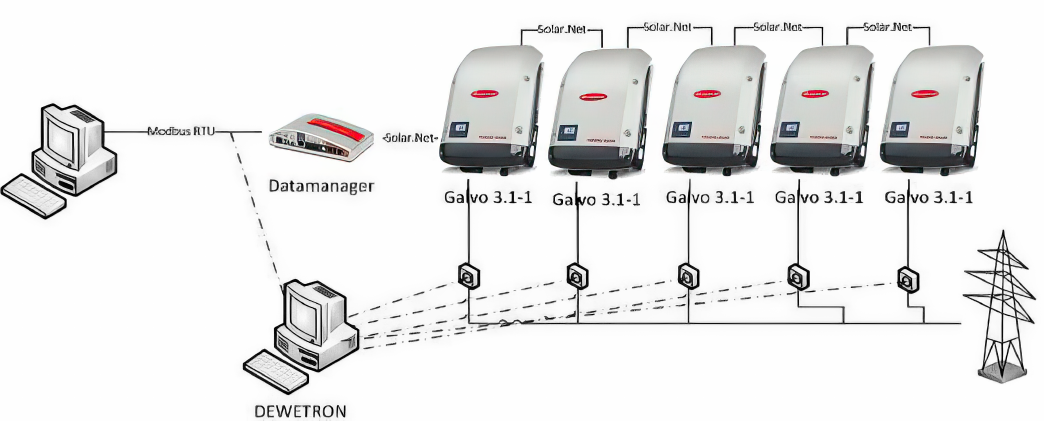
Figure 10. Test setup for remote controllable